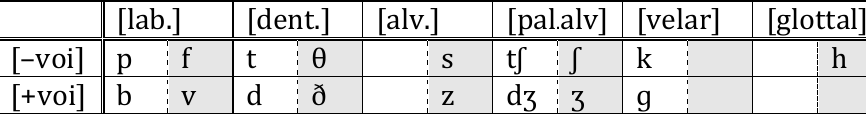
Table 5: The obstruents of Modern English.